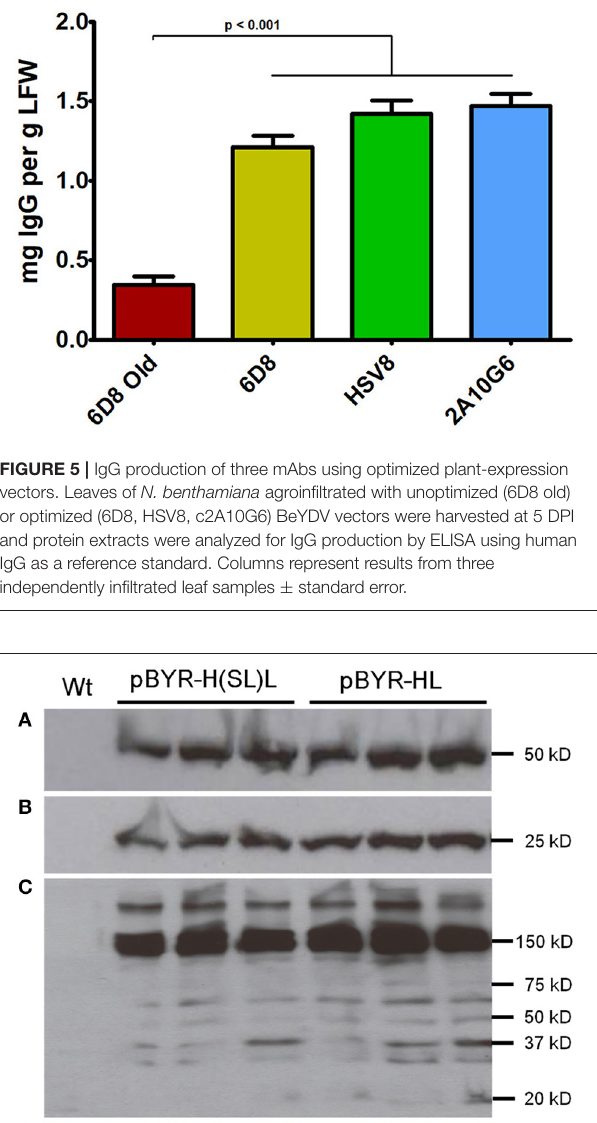
ensure there was no cross-reactivity with native plant